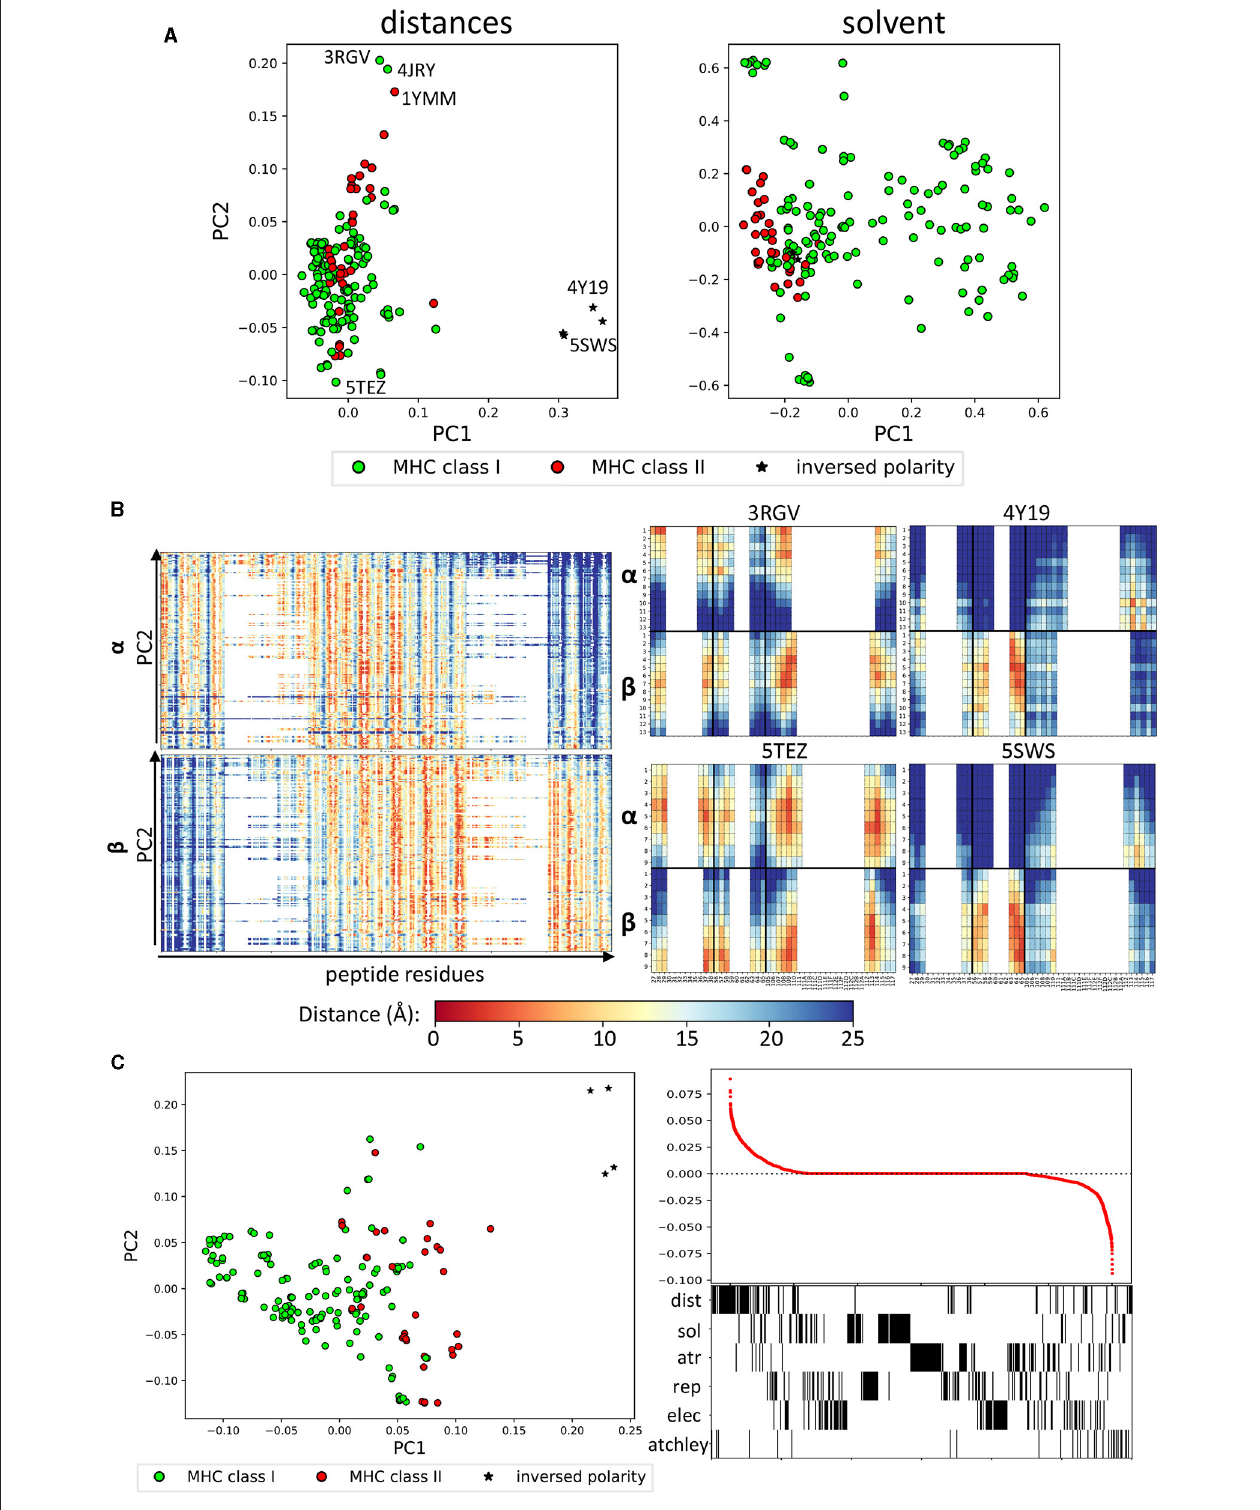
FIGURE 2 | Structural features identify different binding modes. (A) PCA performed on distances and on solvent energies can separate class I and class II complexes (green and red, respectively). The stars indicate the structures that have been reported to have inversed polarity (i.e., the TCRs bind the pMHC complex at 180 ◦